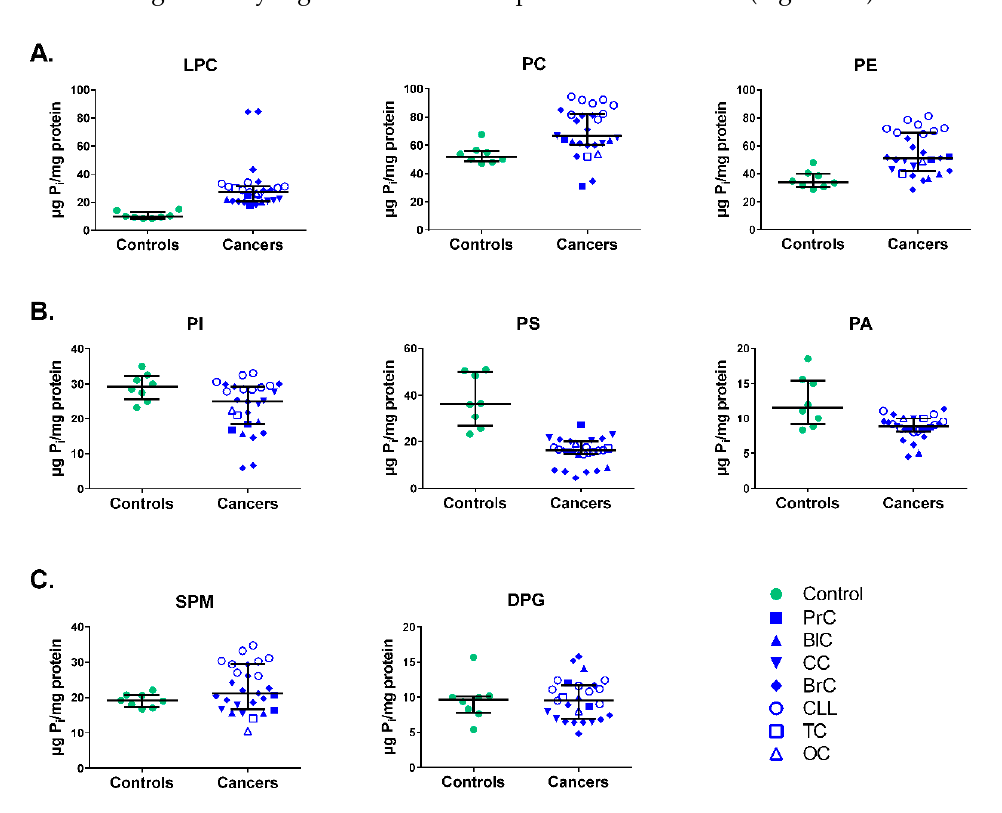
Figure 1. Levels ( µ g Pi/mg protein) of different phospholipids (PL) fractions in membranes of mononuclear cells (MNCs) from healthy individuals (controls) and cancer patients from seven different cancers grouped together (cancers). ( A ) Lysophosphatidylcholine (LPC), phosphatidylcholine (PC), and phosphatidylethanolamine (PE) fractions demonstrating higher levels in cancers; ( B ) Phosphatidylinositol (PI), phosphatidylserine (PS), and phosphatidic acid (PA) fractions with lower levels in cancers; ( C ) Sphingomyelin (SPM) and diphosphatidylglycerol (DPG) did not show any significant differences between controls and cancers. Data from diverse forms of cancers were pooled together; n = 8 for controls; n = 27 for cancers. Statistical differences were assessed using Mann–Whitney test and significance assessed with 95% confidence interval (CI).